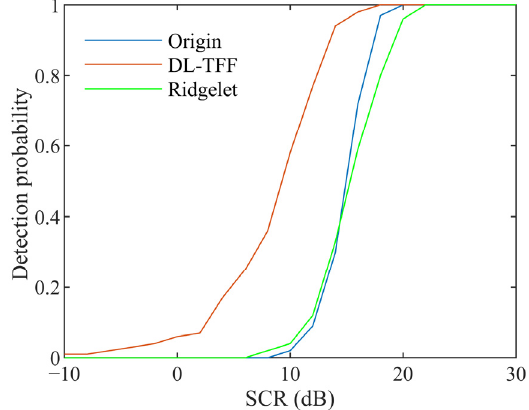
Figure 13. Probability of target detection versus SCR.